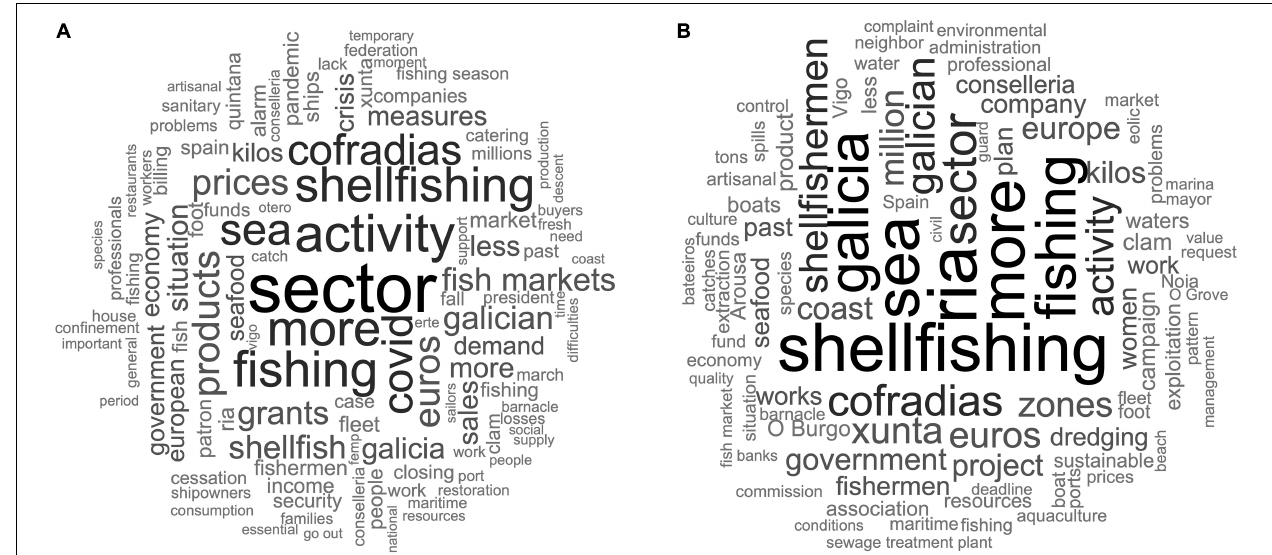
FIGURE 2 | Relative frequency of use of the words included in Galician press news about the fisheries sector, with the keyword covid (A) and without it (B) . Letter size refers to frequency; only the most frequent words ( > 0.09% of the total) were plotted.